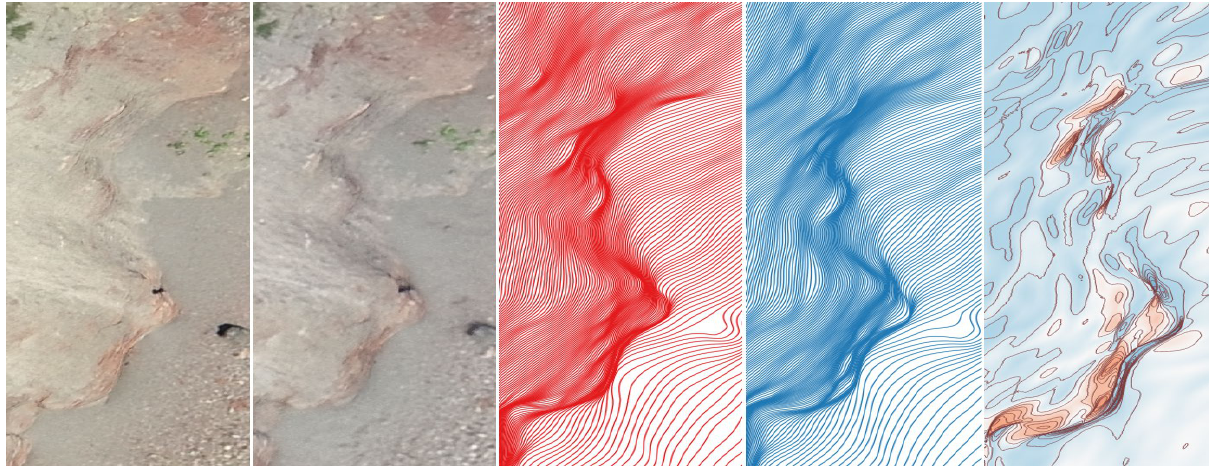
Figure 23 - 3D Digital Orthomosaic for Cliff Analysis. From left to right: 3D Orthomosaic of 31/07/2020; 3D Orthomosaic of 02/08/2010; 5cm Cliff Contours of 31/07/2020; 5cm Cliff Contours of 02/08/2020; Difference Map between 31/07/2020 and 02/08/2020 where the dark pink/orange colours indicate areas of cliff / scree loss which appears to correspond with the difference in shape of the red and blue